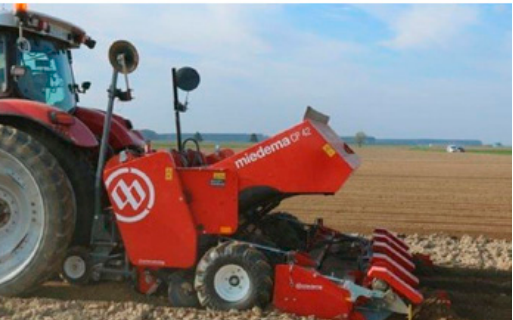
Figure 26. Dewulf Miedema CP 42 potato planter. Reprinted with permission from ref. [72]. Copy- right 2021 Dewulf Industries.